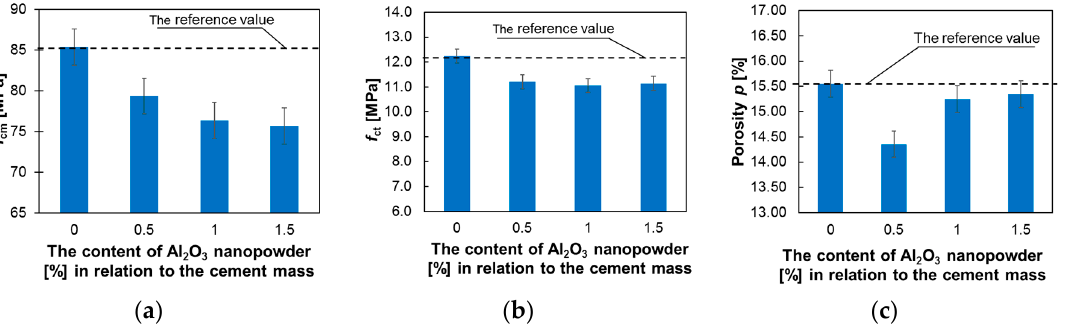
Figure 6. Test results of mechanical properties and porosity of hardened mortars: ( a ) compressive strength, ( b ) flexural strength and ( c ) porosity.